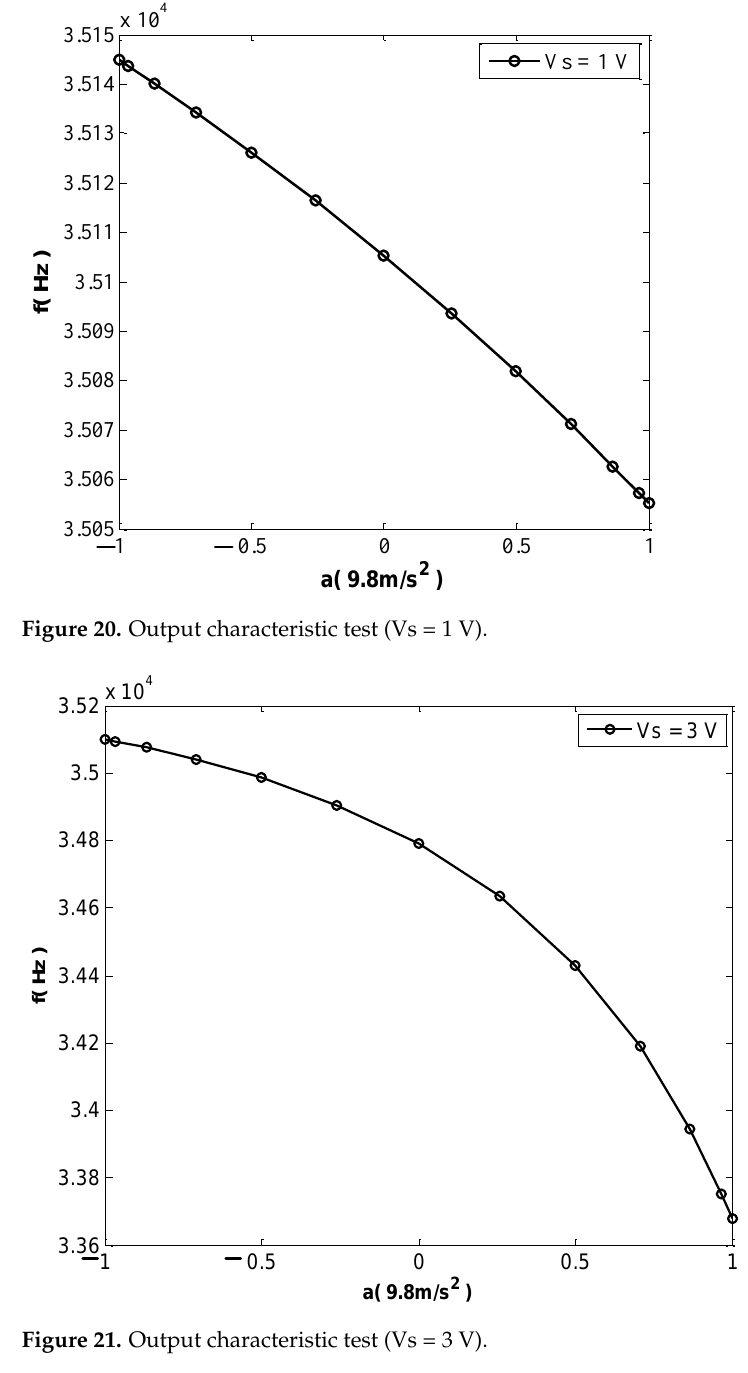
14 of 19 Figure 18. Amplitude frequency curve (single-stage beam). The self-made rotary slide and dial could achieve a precise adjustment of 0.5°, providing acceleration input from − 1 g to 1 g through gravity decomposition. The test instrument is shown in Figure 19, and the corresponding voltage supply mode remained unchanged. Figure 19. Experimental circuit.